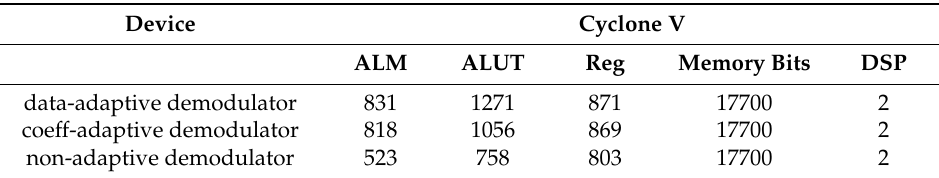
Table 1. Demodulator resources utilization in FPGA implementation.